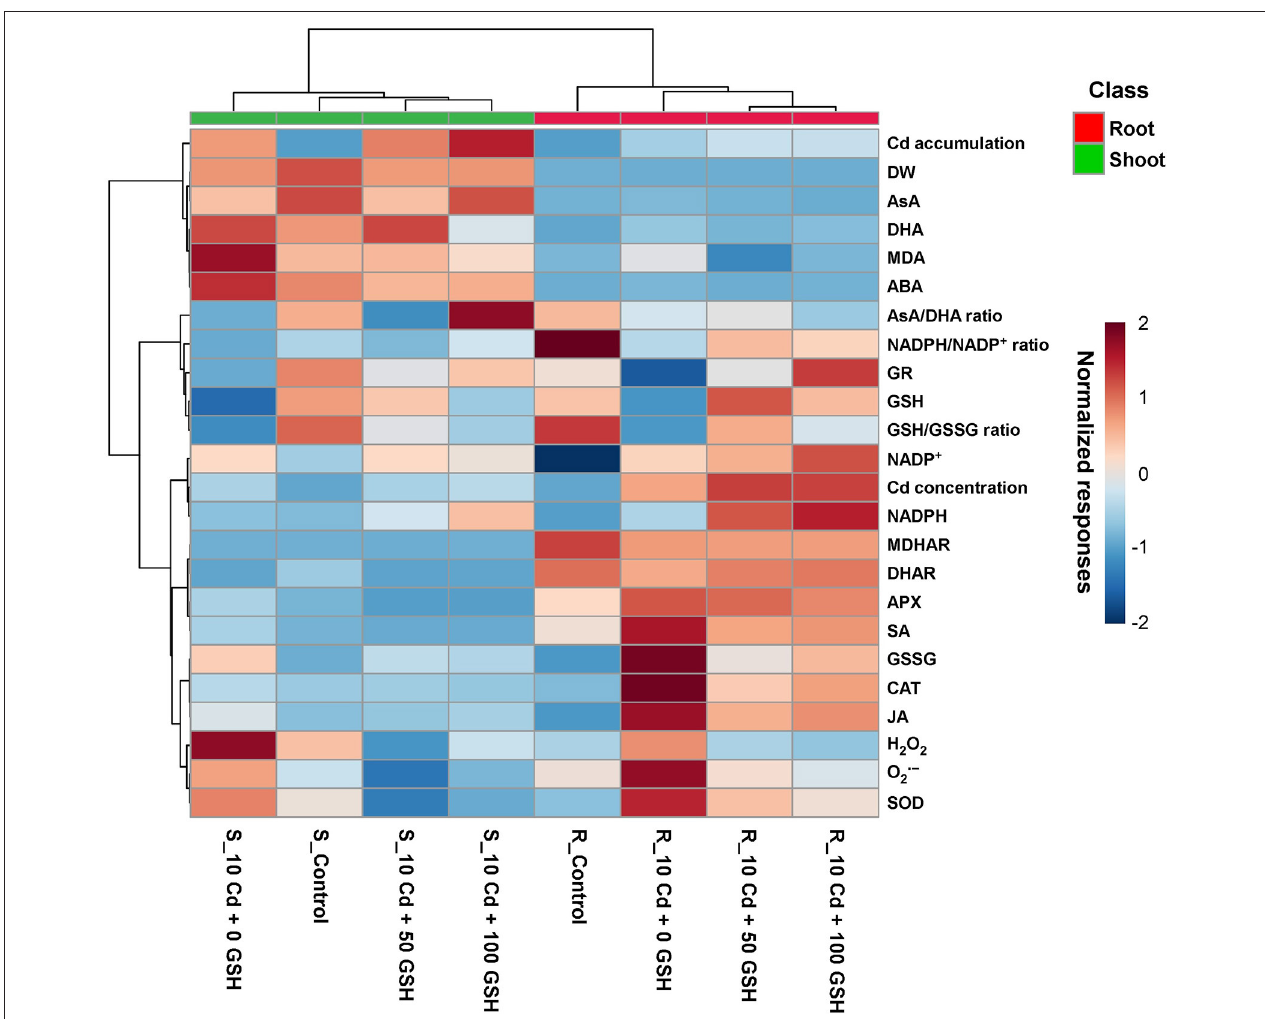
FIGURE 7 | Normalized heatmap matrix of observed responses in ROS levels, AsA/GSH/NADPH redox status, and stress-associated hormone status in the roots and shoots of Cd-stressed plants treated with different GSH levels. R, root; S,